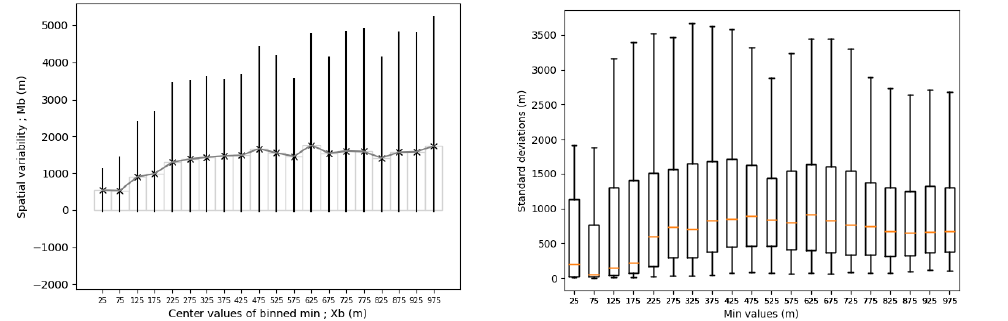
Figure 7. Same as Figure 6 for the minimum